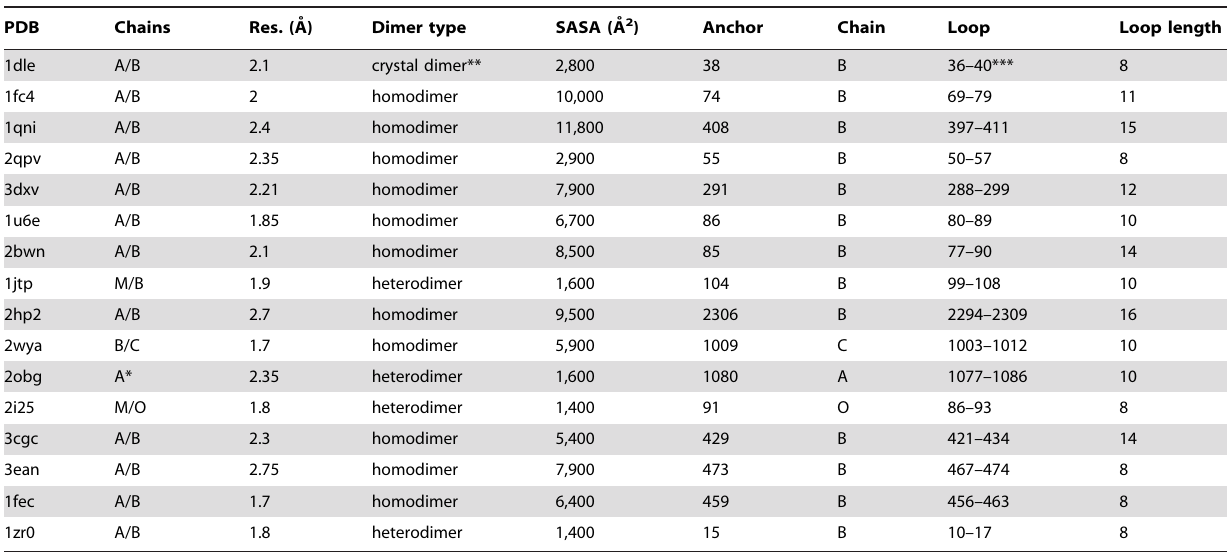
Table 2. Input structures and accessory